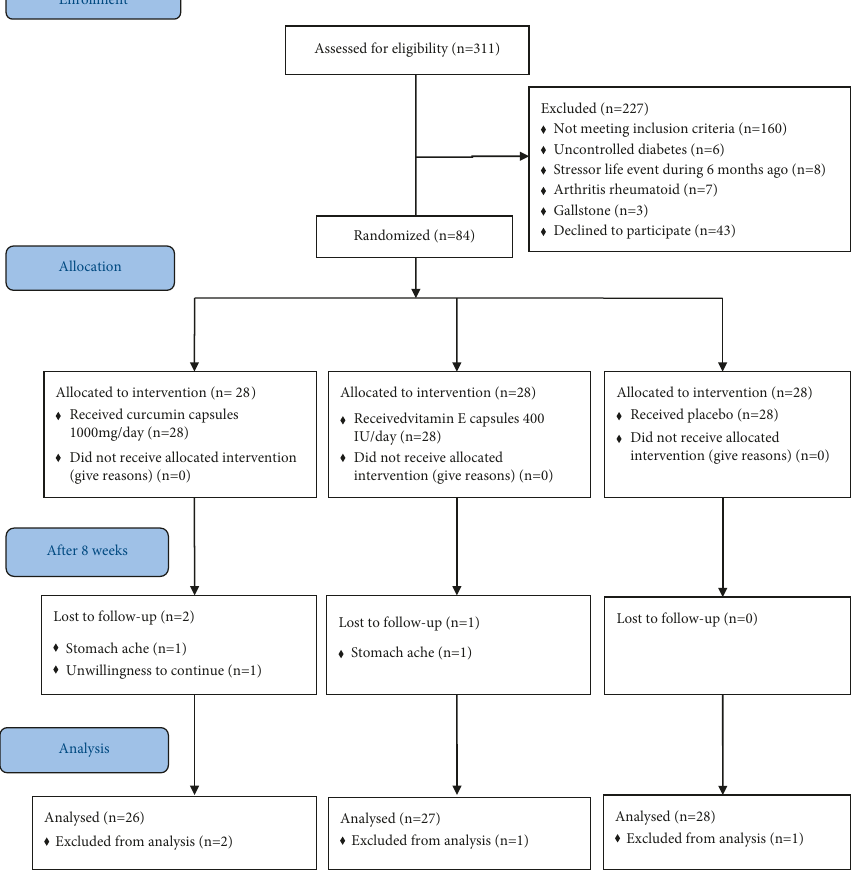
Figure 1: Flow diagram of participants’